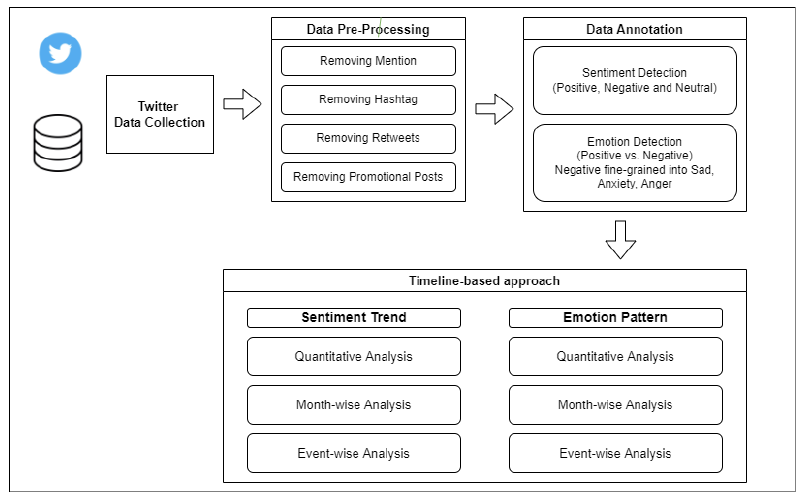
Figure 2. Overview of proposed framework for detecting sentiment trend and emotion pattern.